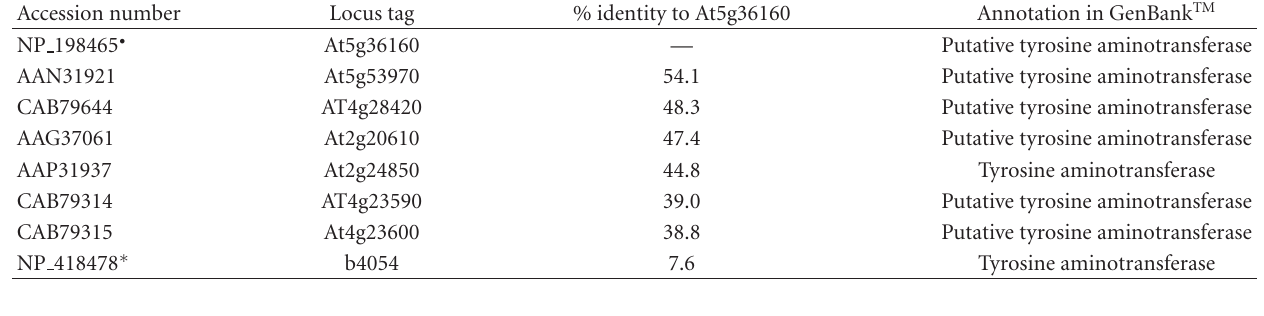
Table 1: Locus tag and accession numbers for TATs from Arabidopsis and from E. coli . The accession numbers and predicted function for the enzymes were obtained from GenBank TM (http://www.ncbi.nlm.nih.gov/Genbank/) and from The Arabidopsis Information Resource (TAIR) (http://www.arabidopsis.org/). The closed circle refers to the Arabidopsis plant enzyme that was actually studied and the asterisk denotes the accession number of the E. coli TAT enzyme.